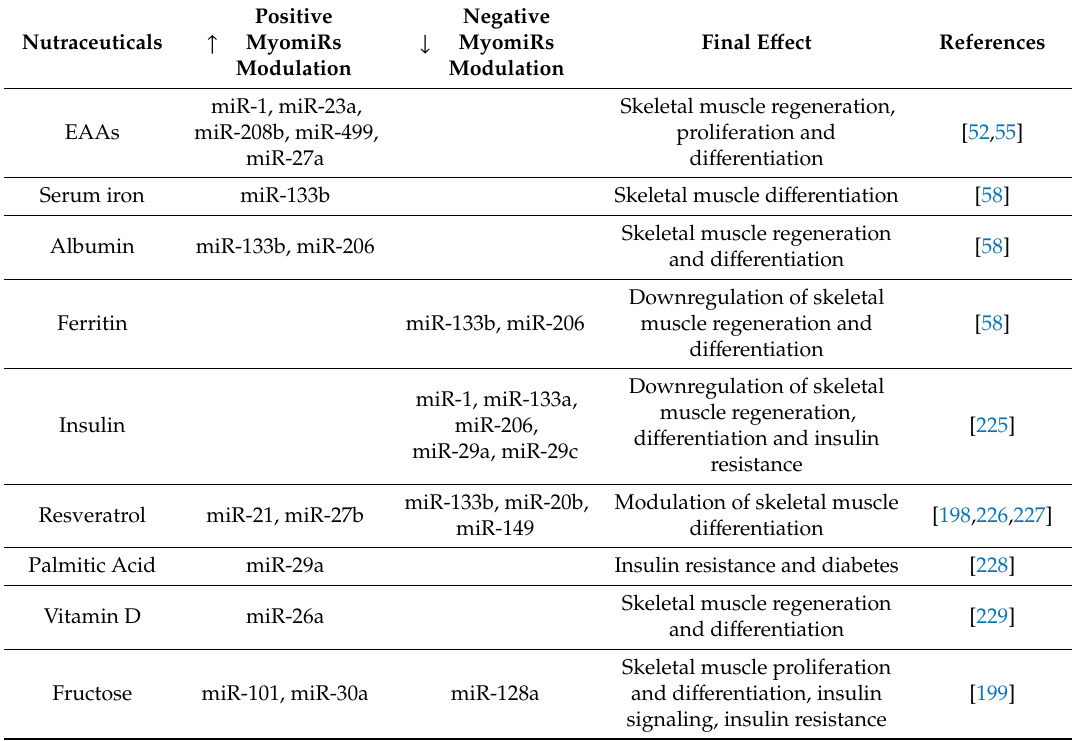
Table 1. Dietary compounds that have been shown to influence miRNAs levels in skeletal muscle.